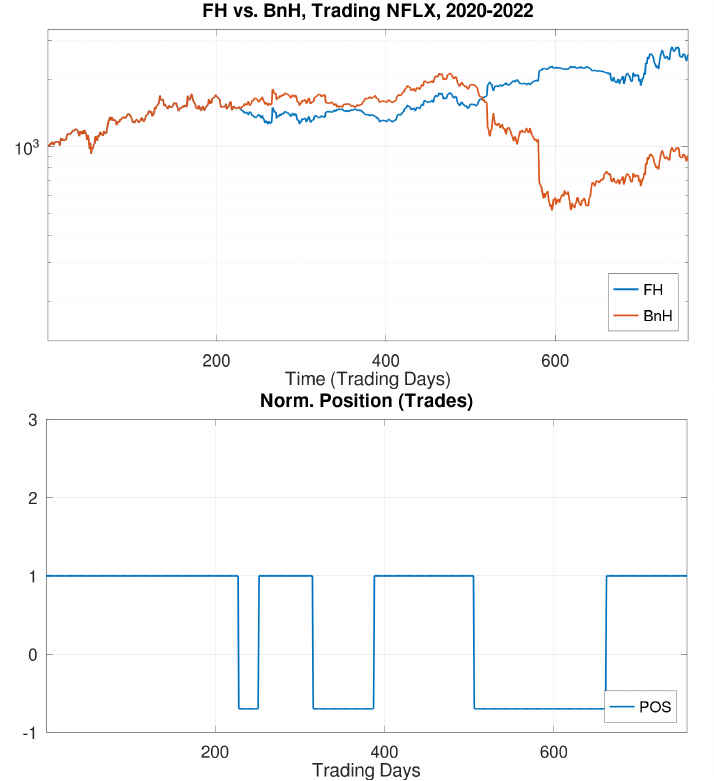
Figure 7. Performance of a FastHedge trading strategy for NFLX stock in the 3-year period 2020–2023, including portfolio gains as well as the trades